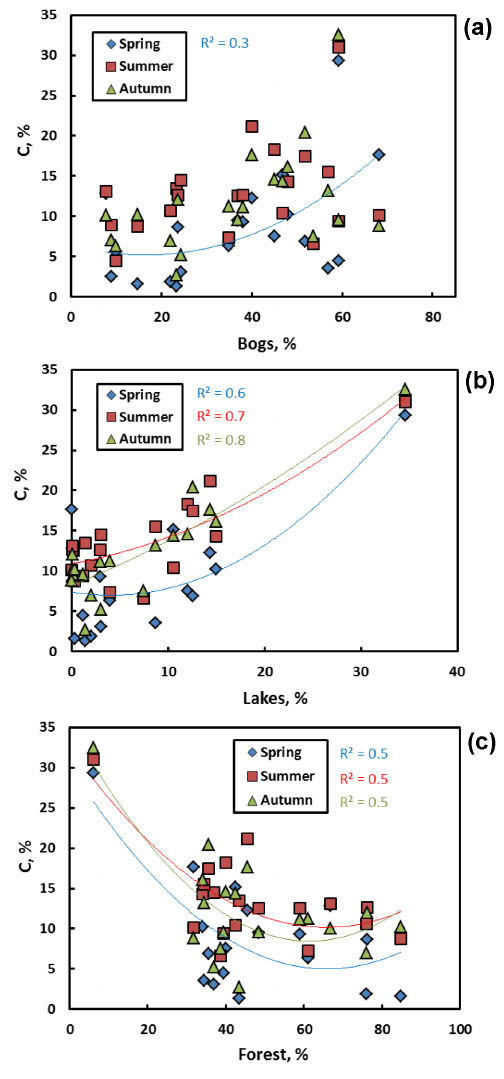
Figure 4. The dependence of C concentrations in RSM (%) on the coverage of watershed by bogs (a) , lakes (b) and forest (c) . The solid lines represent second-degree polynomial fitting of the data with regression coefficients shown for each season in corresponding panels.